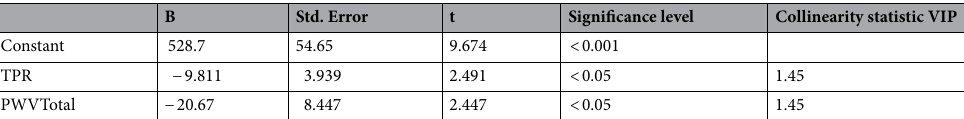
Table 4. Least square multiple regression analysis for left ventricle peak-filling rate indexed (FR P(i) ) as determined from CMR time-volume curves in 36 healthy young and 16 healthy middle-aged subjects (unstandardized coefficients).